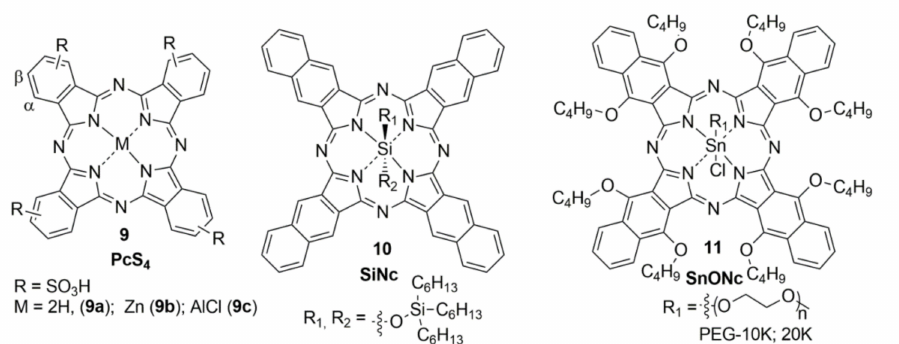
Figure 8. Chemical structures of phthalocyanines (PcS4, 9 ) and naphthalocyanines, SiNc ( 10 ) and SnONc ( 11 )).